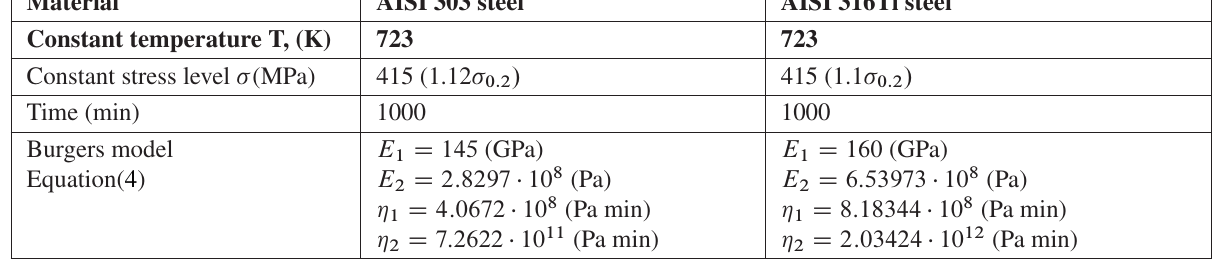
Table 2. Creep tests – Temperatures and stress levels.